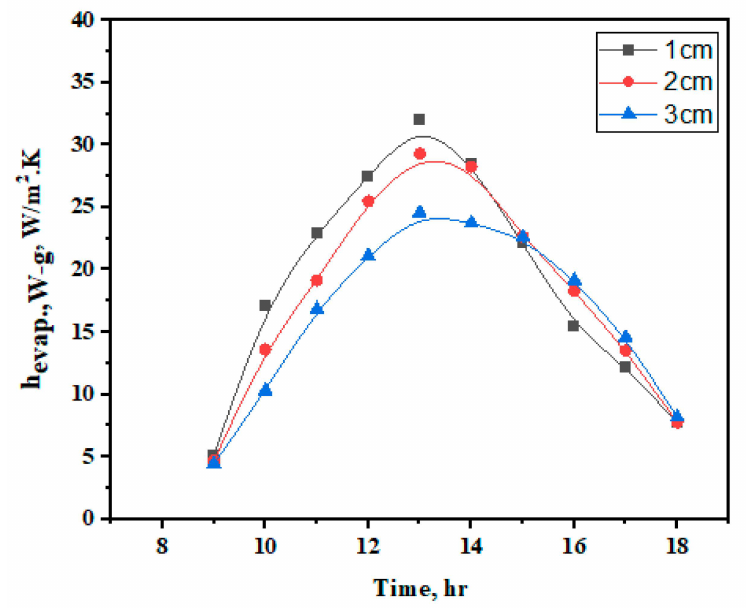
Figure 7. Influence of water depth on heat transfer coefficient by